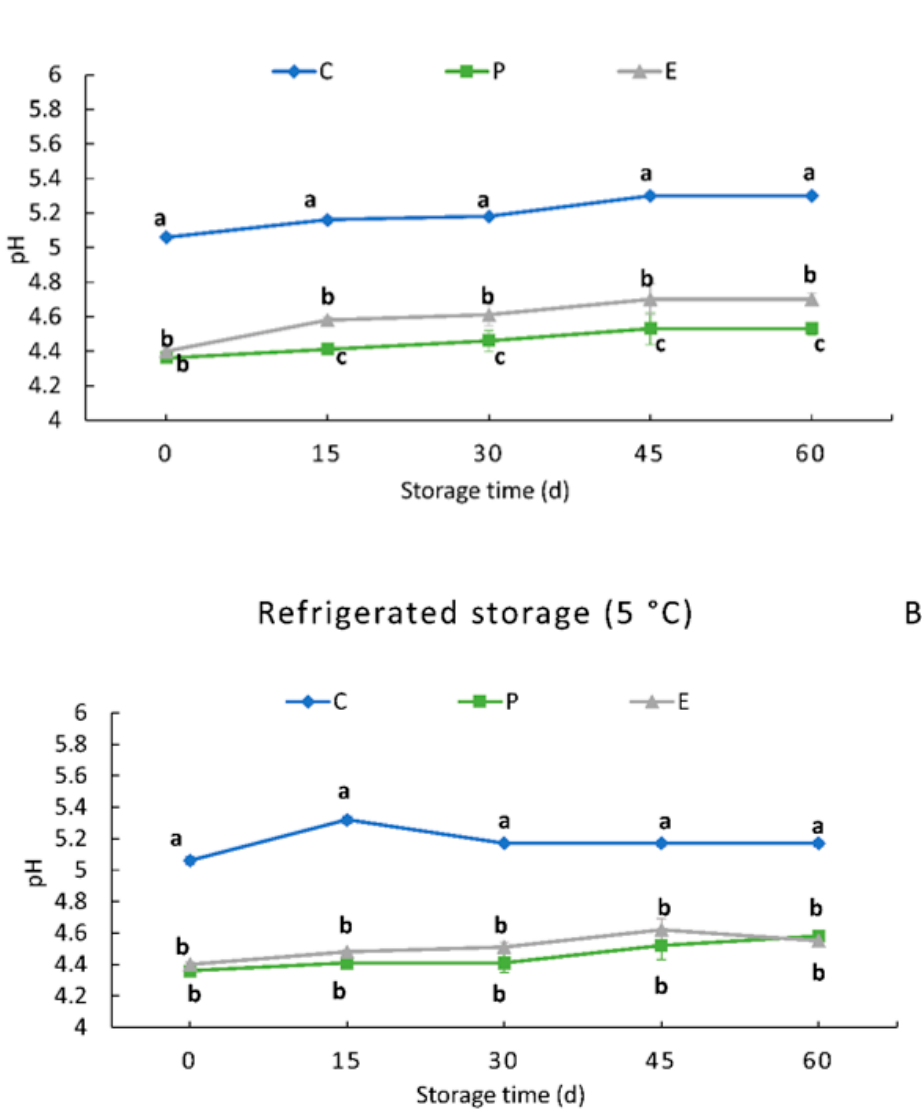
Figure 2. ( A ): Evolution of pH (means ± standard deviations) during room temperature storage (20 ◦ C) of Salamines Criollos formulated with microencapsulated L. plantarum BFL (E) and free L. plantarum BFL (P). ( B ): Evolution of pH (means ± standard deviations) during refrigerated storage (5 ◦ C) of Salamines Criollos formulated with microencapsulated L. plantarum BFL (E) and free L. plantarum BFL (P). The different letters indicate significant differences ( p < 0.05) between treatments on the same day under the same storage